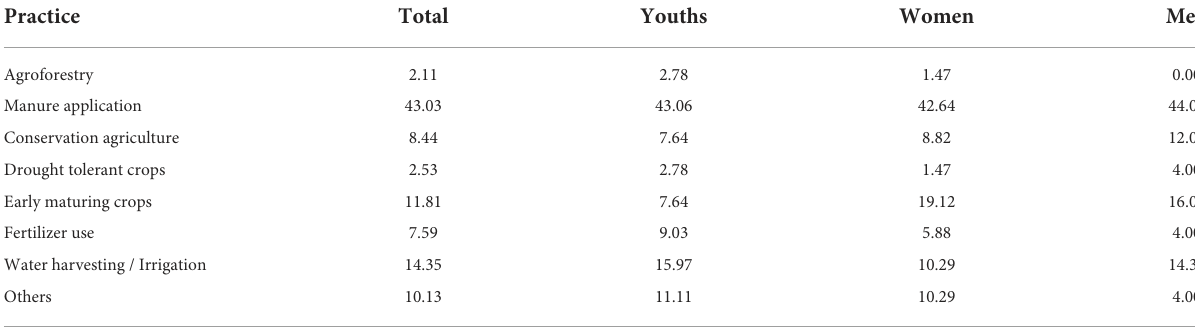
Drought tolerant crops